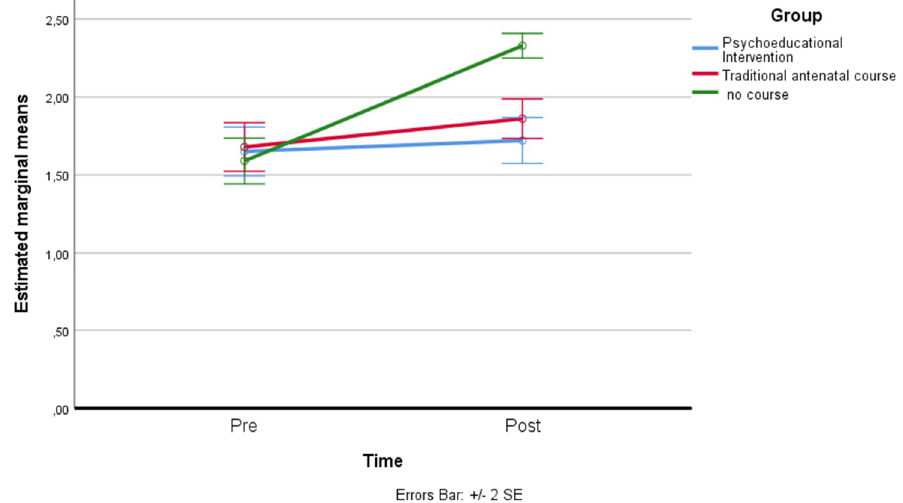
Figure 1. Estimated marginal means of threat anxiety.